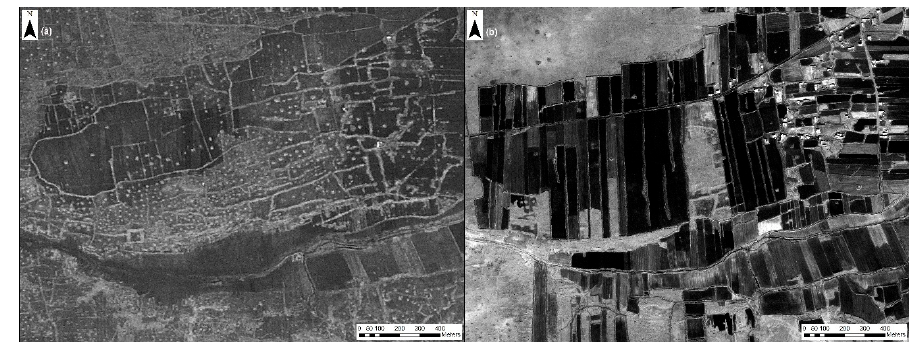
Figure 15. Comparison between Corona KH4-B (17 December 1969) and Panchromatic Ikonos (2 March 2002) showing the changes, and areas of de-rocking and areas that remain ‘un-cleared’.